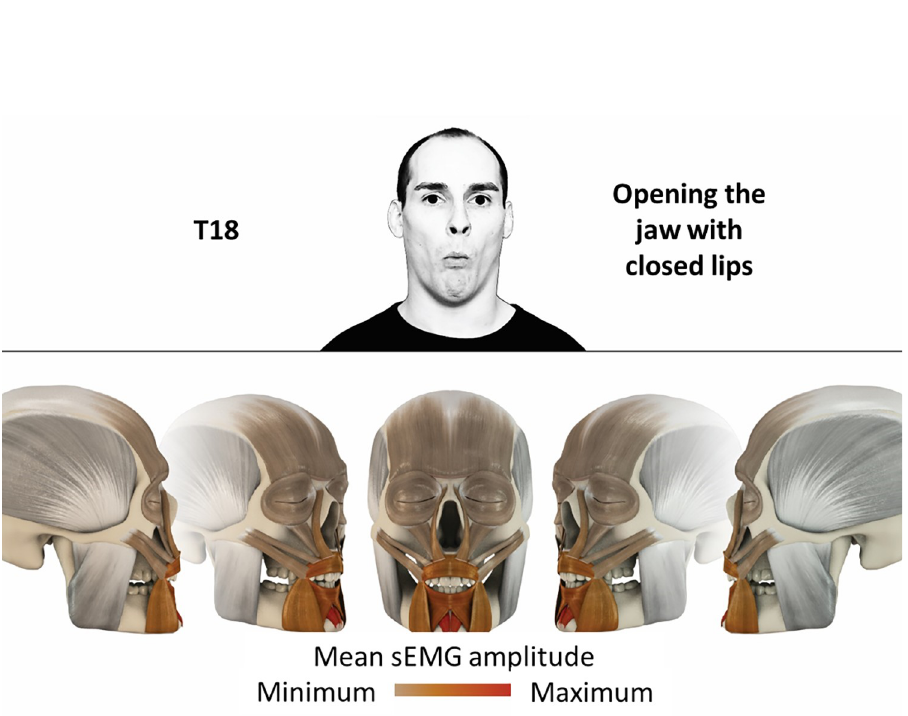
Fig 19. Color-coded facial muscle activation pattern of task T18. Opening jaw with closed lips. Animation by Jonas Laustro¨er.